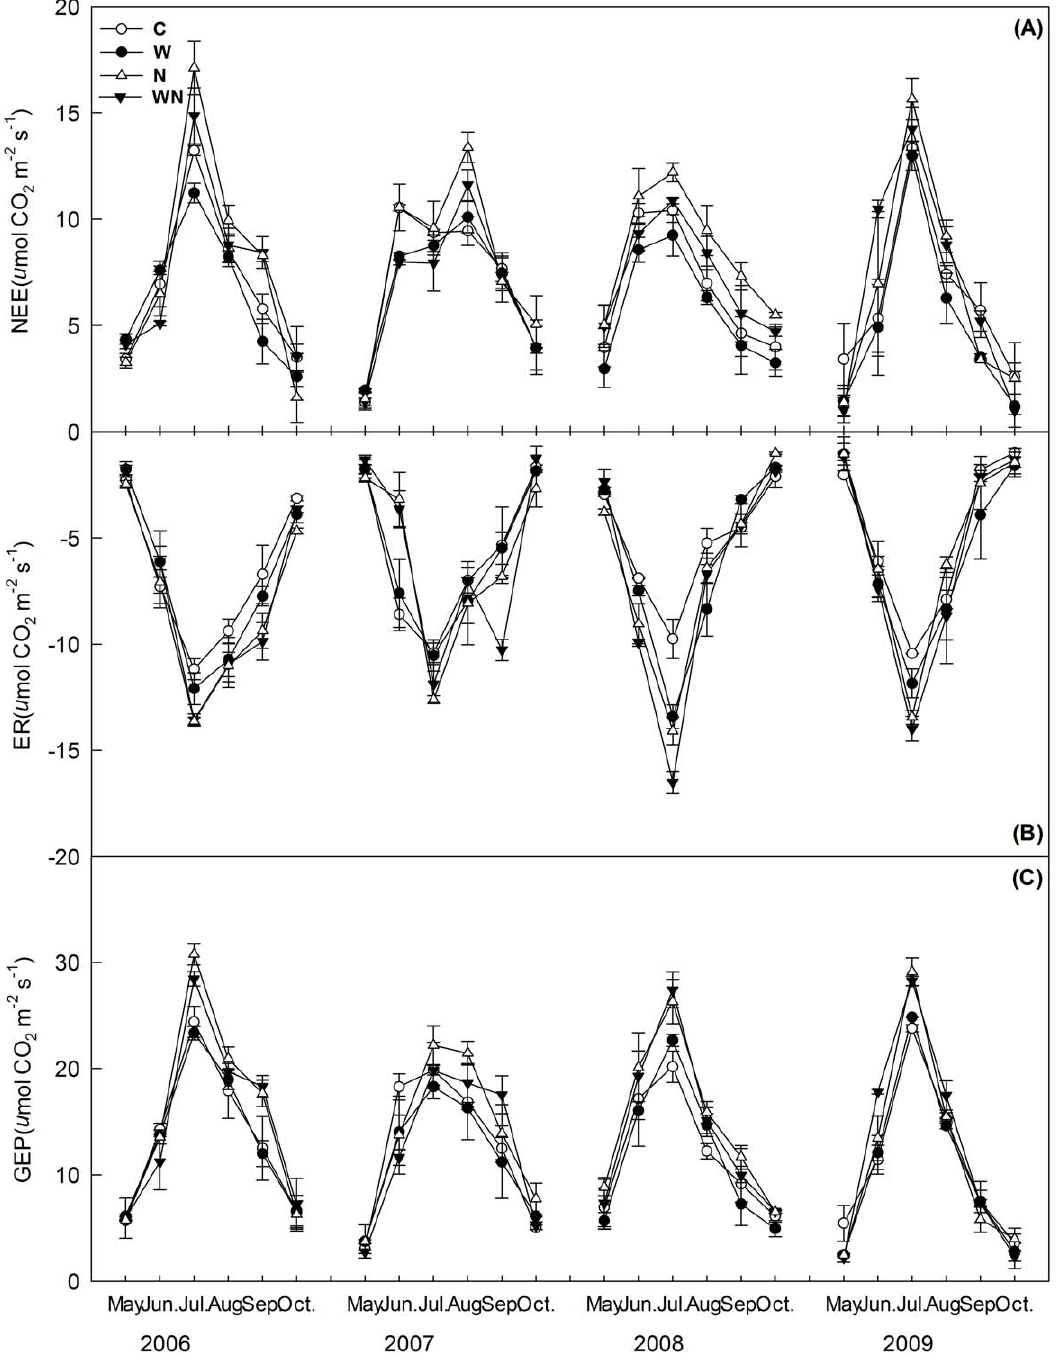
Figure 2. Seasonal dynamics (mean 6 SE; n=6) of net ecosystem CO 2 exchange (NEE), ecosystem respiration (ER), gross ecosystem productivity (GEP) in response to warming (1.8 u C) and N addition (10 g m 2 2 yr 2 1 ) in the Songnen grassland. C = control, W = warming, N = N addition, WN = combined warming and N addition.